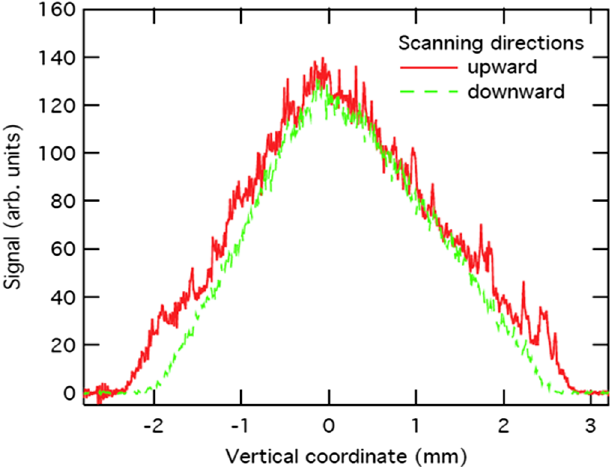
12 (color online). Wire scans in opposite directions. Solid line denotes wire moving in the upward direction; broken line denotes wire moving in the downward direction.